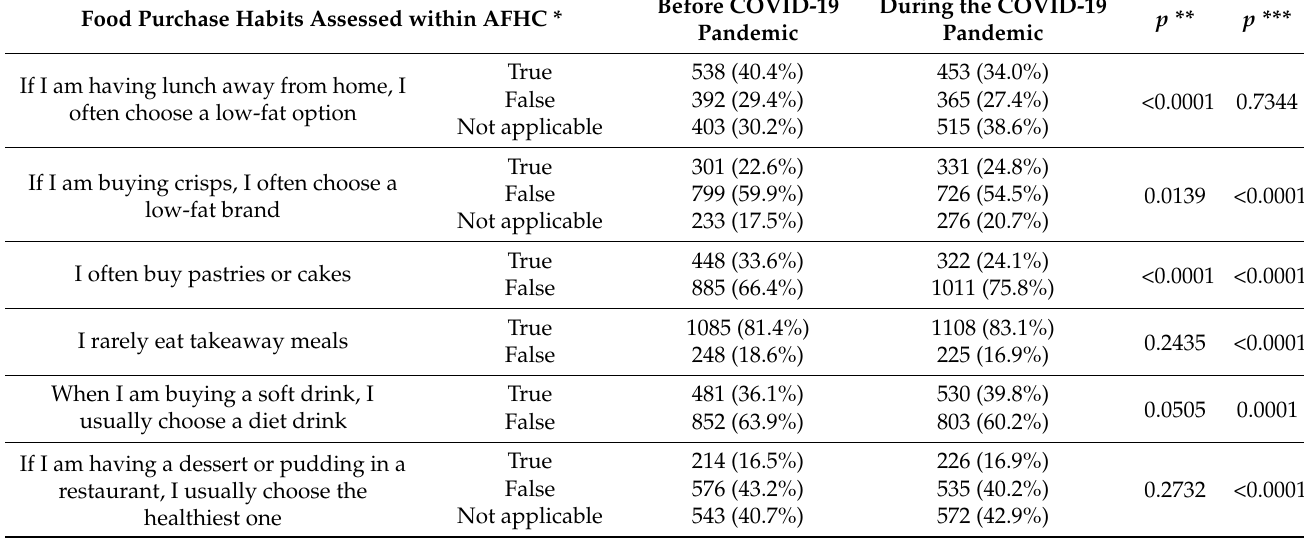
Table 1. The food purchase habits assessed while using Adolescents’ Food Habits Checklist (AFHC) in the period before the COVID-19 pandemic and during the COVID-19 pandemic, as declared by the adolescents from the Diet and Activity of Youth during COVID-19 (DAY-19) Study cohort ( n =